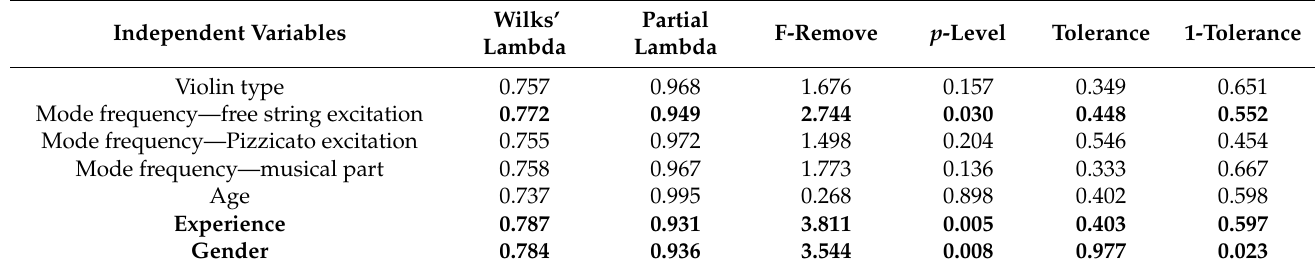
Table 6. The results of the multifactor discriminant analysis regarding sound amplitude.